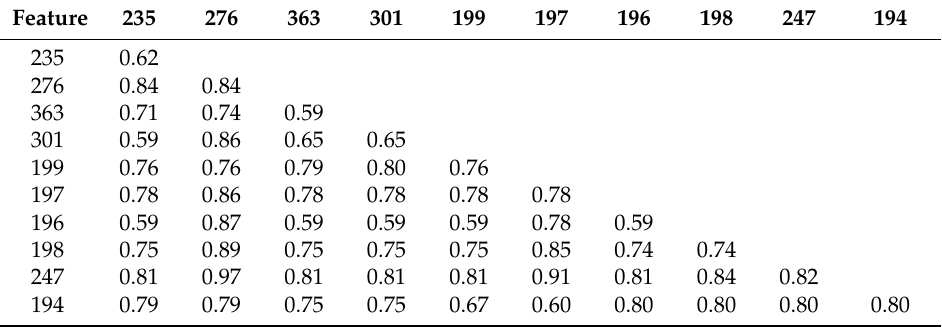
Table 9. E ff ect of selected features for level